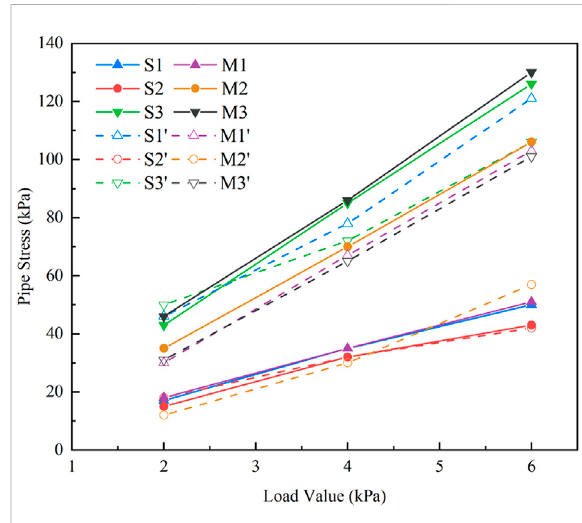
FIGURE 12 Pipeline stress at each point under the non-central loading.